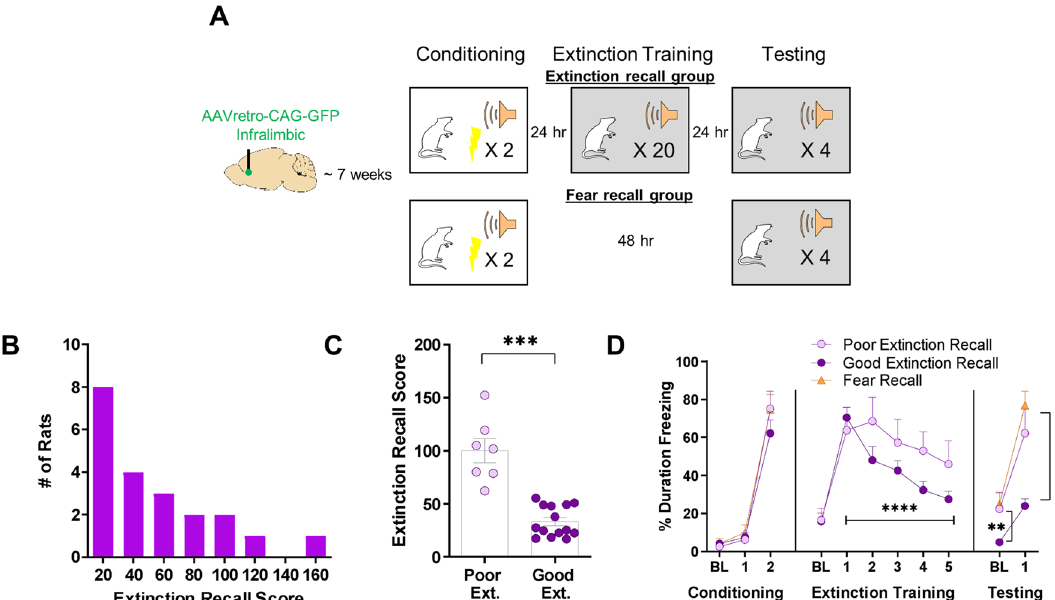
Figure 2. Individual variation in extinction recall. ( A ) Schematic representation of surgical and behavioral procedures. ( B ) Frequency distribution demonstrating individual variation in extinction recall scores. ( C ) Evidence that groups created on the basis of calculated extinction recall scores represent two distinct phenotypes. ( D ) Average percent time spent freezing for poor extinction, good extinction, and fear recall rats during 30 s bins in the fear conditioning session, during 20, 30-s tones collapsed into 5 blocks (4 tones each) in the extinction training session, and during four tones in the extinction recall and fear recall sessions. Error bars represent standard error of the mean. * p < 0.05, ** p < 0.01, *** p < 0.001, **** p <